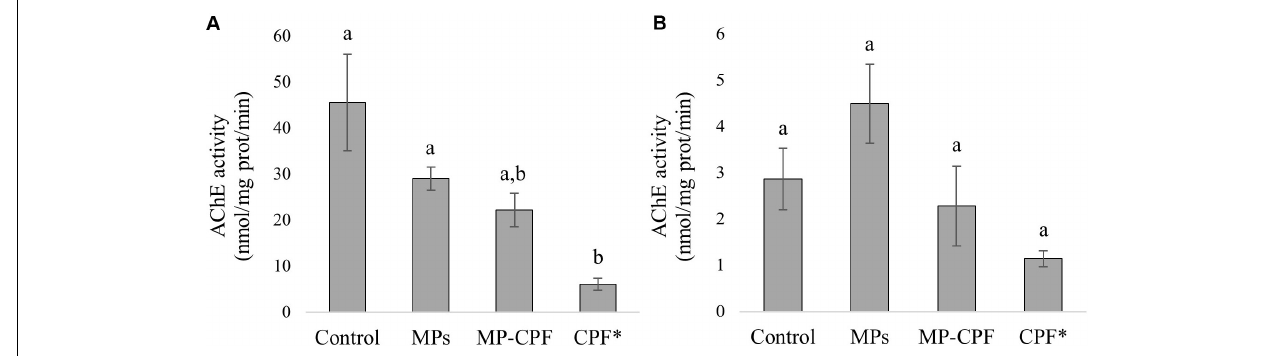
FIGURE 4 | AChE activity (nmol/mg protein/min, mean values ± SE) in fish (A) brain and (B) liver. Different letters (a,b) indicate statistically different groups ( p < 0.01). *Fish from the CPF group were euthanized and sampled after two weeks of